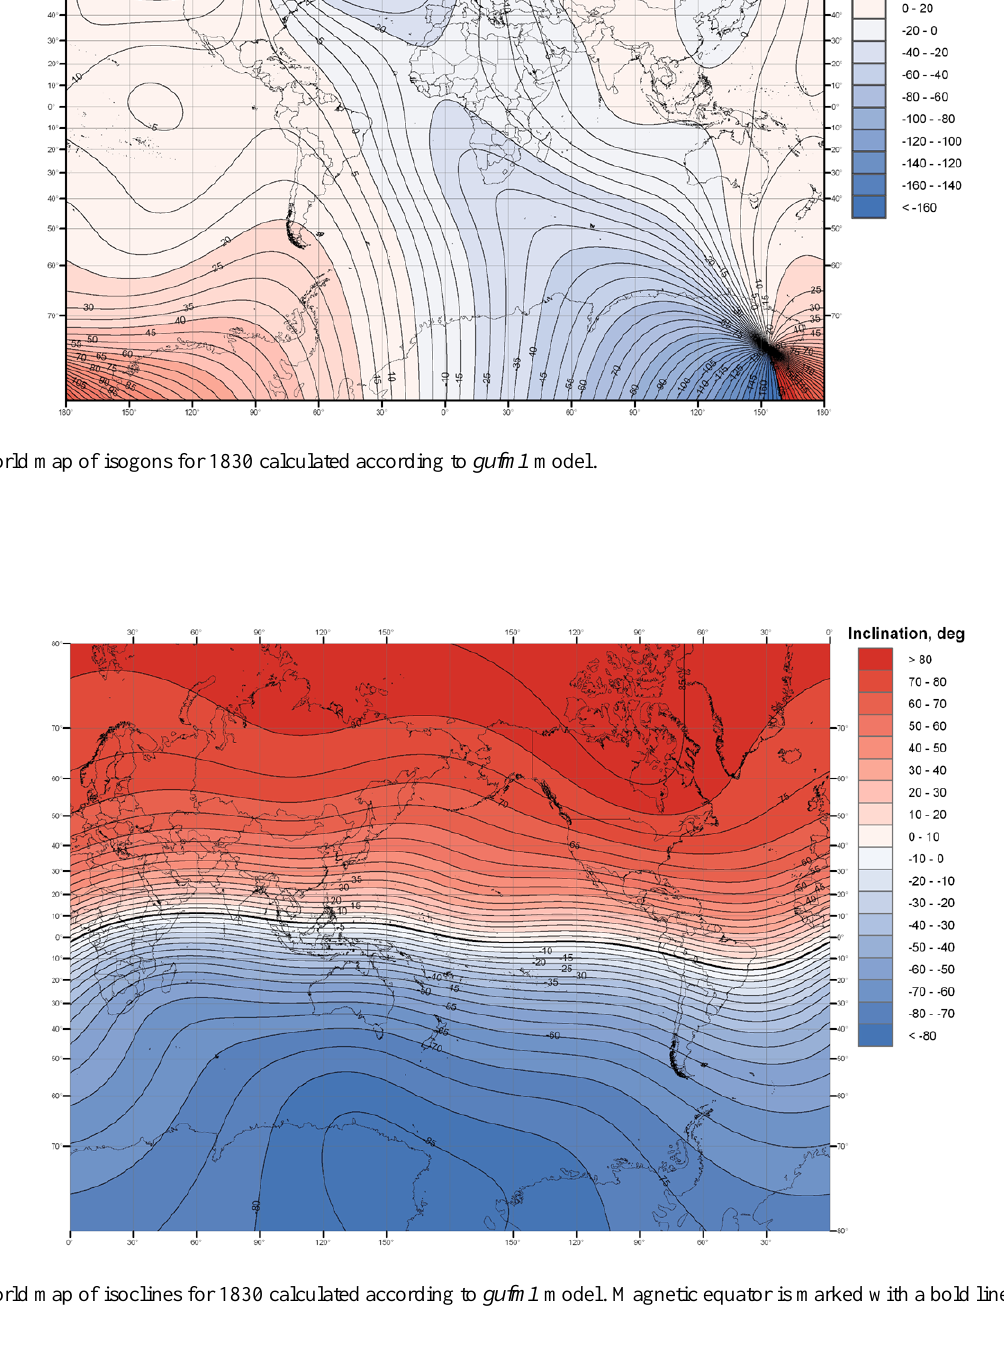
Hist. Geo Space Sci., 1, 63–76, 2010